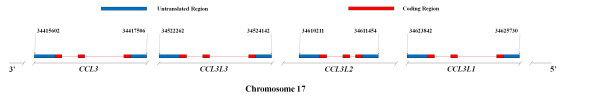
CCL3L gene cluster. Annotation, orientation and mapping of the gene cluster CCL3 (geneID: 6348), CCL3L1 (geneID: 6349), CCL3L2 (geneID: 390788) and CCL3L3 (geneID: 414062) in the chromosome 17 genomic sequence.